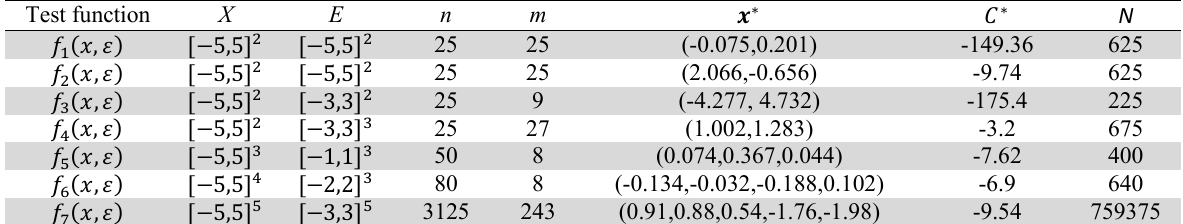
Results of the first method for the test functions Test